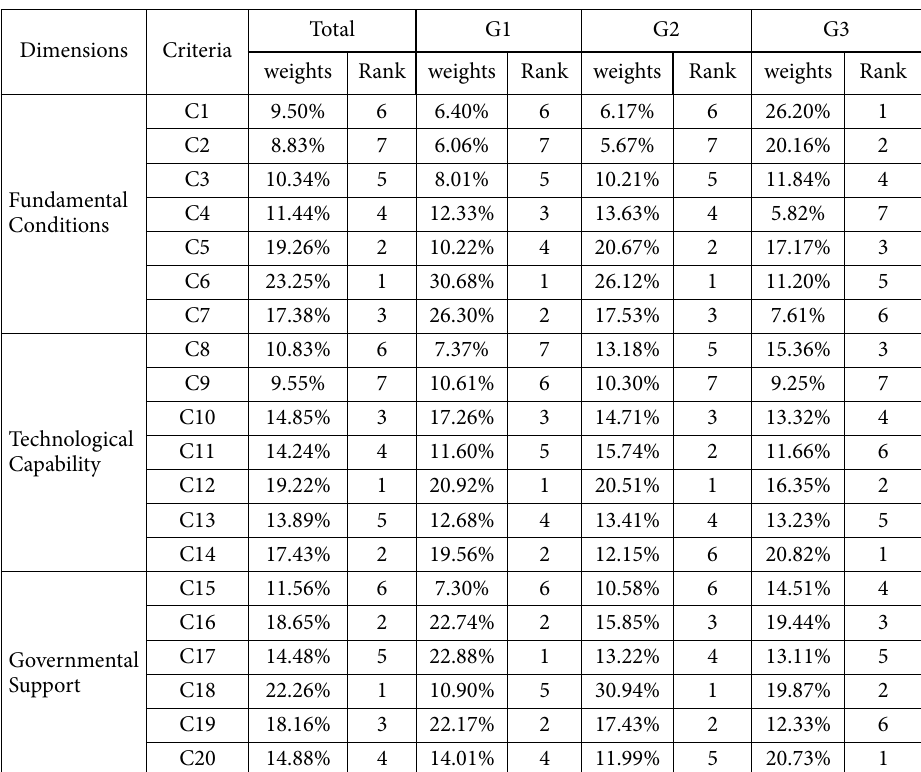
Table 4. Calculation results of the criteria weight